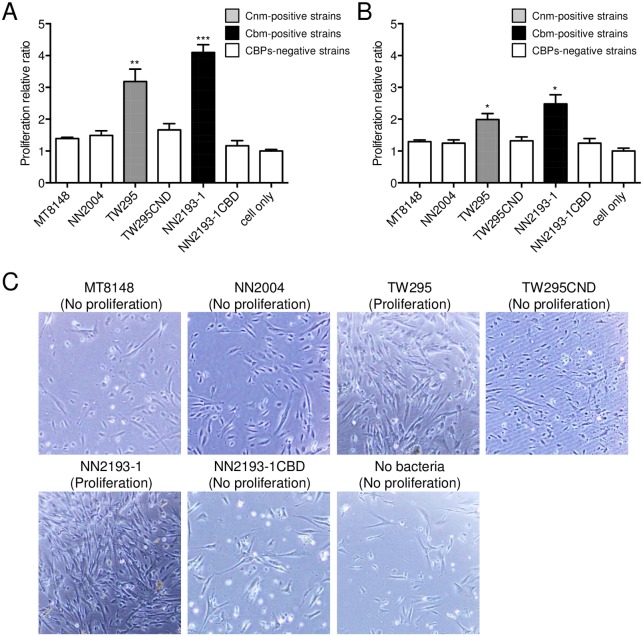
Effects of S. mutans infection of HDPFs.MTT assay results following infection of HDPFs from a (A) primary and (B) permanent tooth with S. mutans strains at an MOI of 100 for 6 h. Data are expressed as the relative ratio standardized to non-infected HDPFs and the mean ± SD, with analysis of three independent experiments. CBP-positive strains showed significant differences compared with CBP-negative strains (Student’s t-test; *P<0.05, **P<0.01, ***P<0.001). (C) Light microscopy images showing morphology of HDPFs from a primary tooth infected with S. mutans at an MOI of 100 for 6 h.